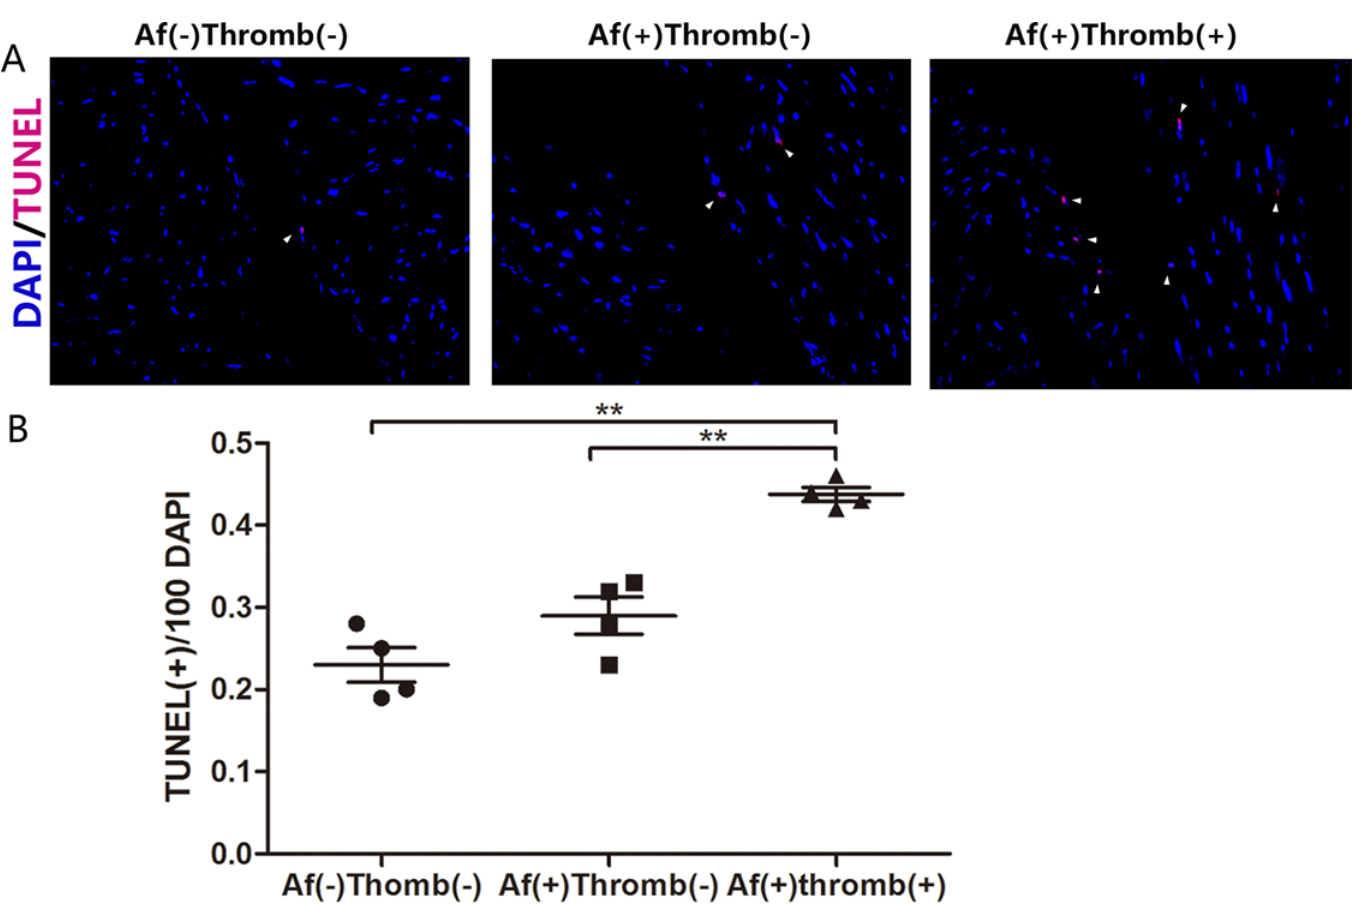
Fig 3. Increased cardiomyocyte death and thrombogenesis in MS patients. (A) TUNEL-positive cells are primarily located in the atrial endothelium. (arrowhead) (B) Frequency of apoptotic cells in the atrium of MS patients as indicated by TUNEL-positive cells per 100 DAPI in three groups. ** denotes P <